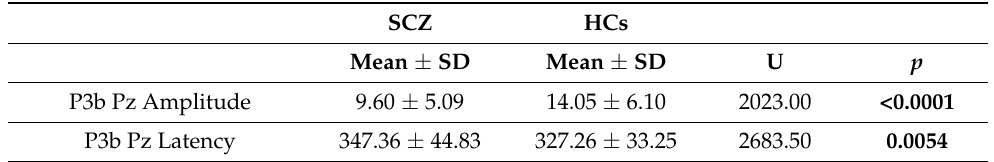
Table 2. Comparison between SCZ and HCs of P3b amplitude and